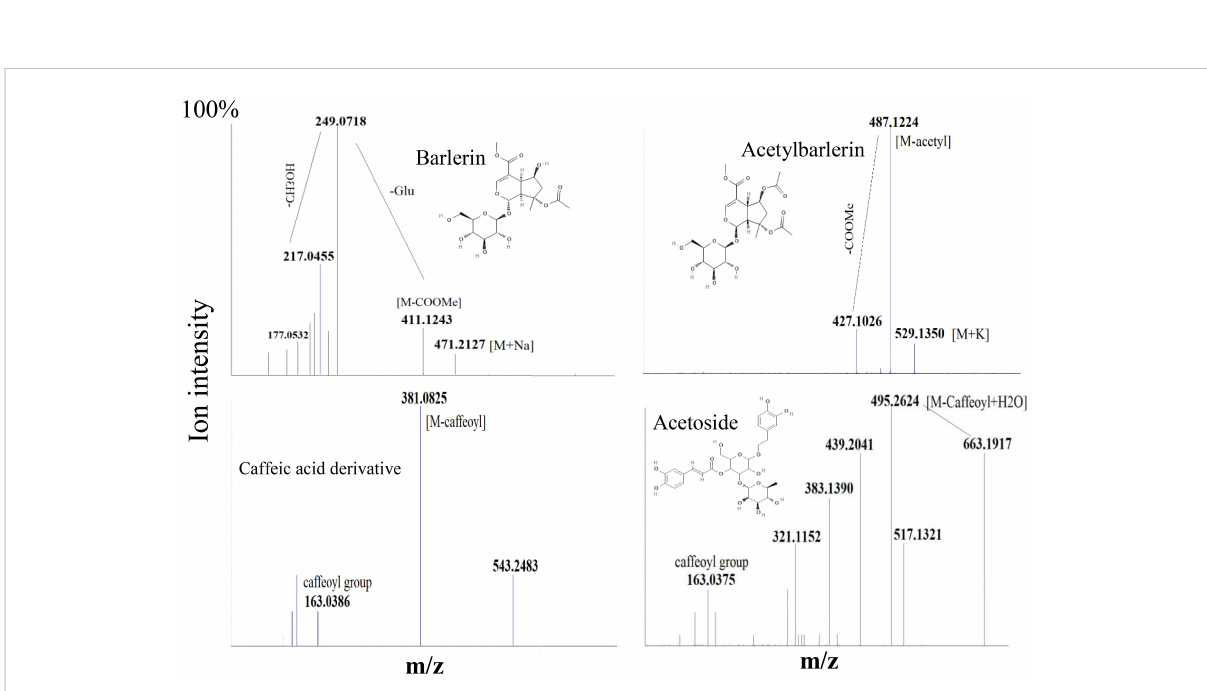
FIGURE 5 MS/MS spectra of some selected ions, showing fragmentation pattern of Barlerin, Acetylbarlerin, Caffeic acid derivative and Acetoside.